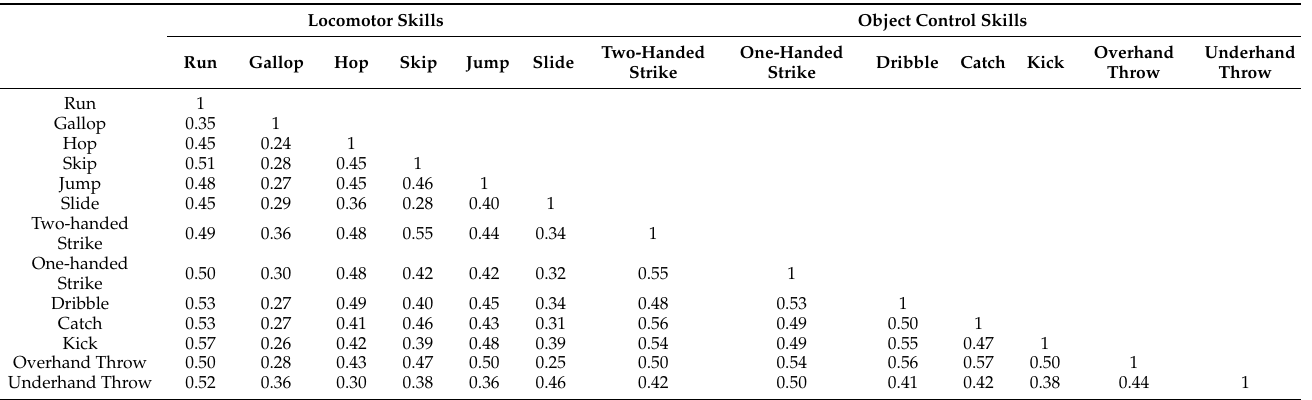
Table 2. Correlations among motor